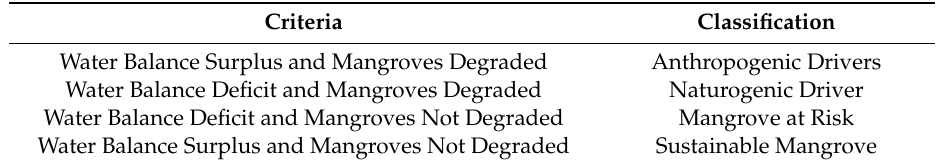
Table 6. Relationship classifications between mangrove forests’ water balance and mangrove